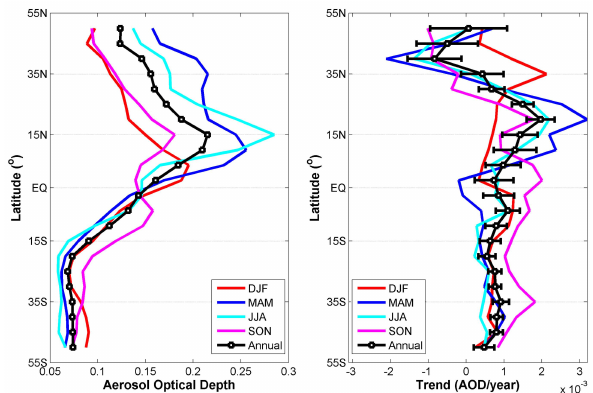
Fig. 14. The 13 yr SeaWiFS zonally averaged AOD values (left) and the corresponding trends per year (right) from 55 ◦ S to 55 ◦ N (land and ocean) for annual and four seasonal means denoted by different color lines. The horizontal bars on the right panel represent the uncertainties associated with the calculated annual trends for each latitude